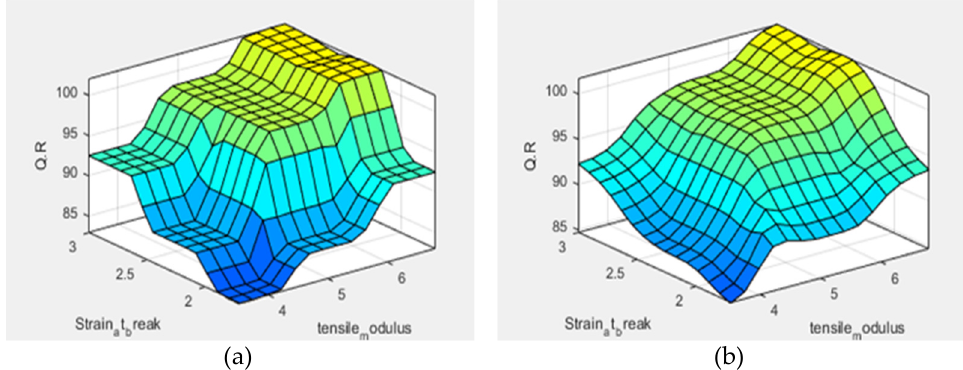
Figure 9. Surface view of tensile modulus (X-axis) and strain at break (Y-axis) effect on jute yarn quality (Z-axis); ( a ) for triangular membership function and ( b ) gaussian membership function.